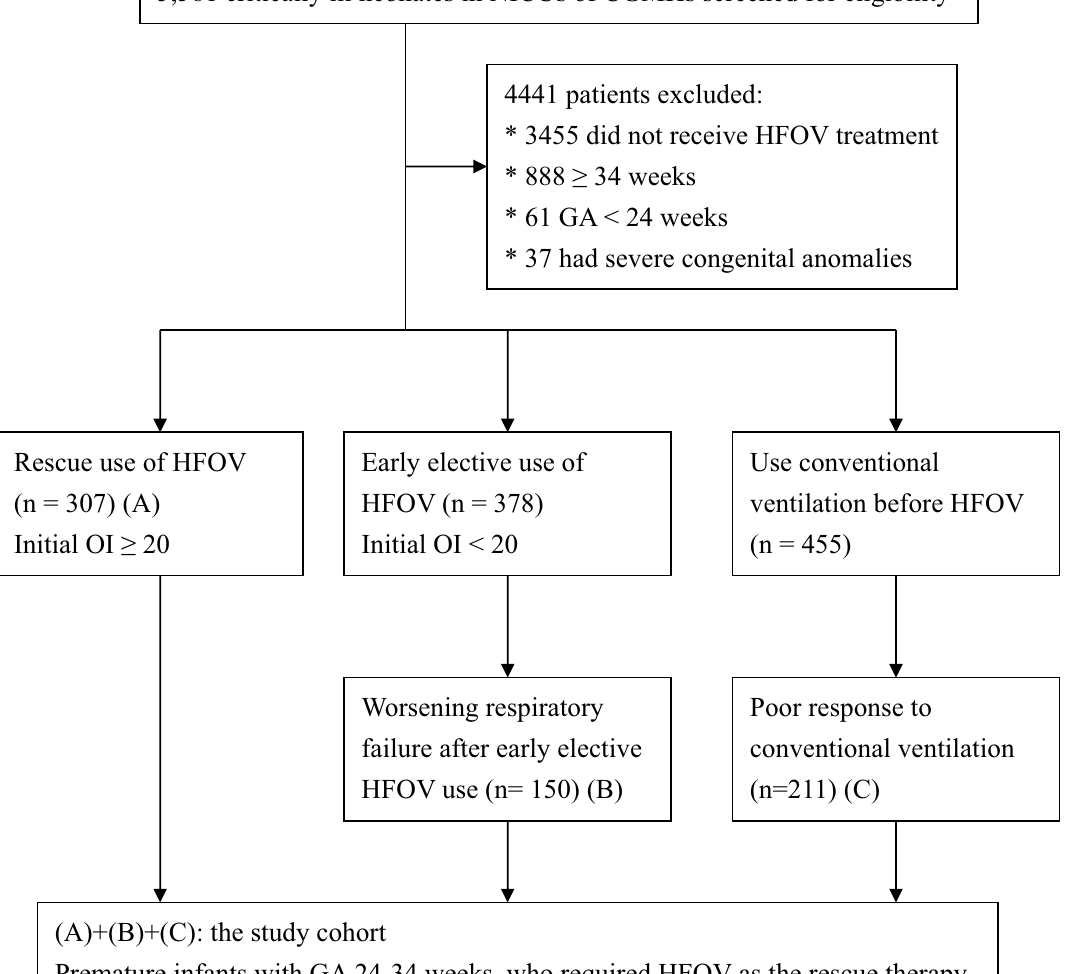
Figure 1. Flow chart and enrollment of the study cohort. HFOV: high frequency oscillatory ventilation; OI: oxygenation index; GA: gestational age; NICU: neonatal intensive care unit; CGMH: Chang Gung Memorial